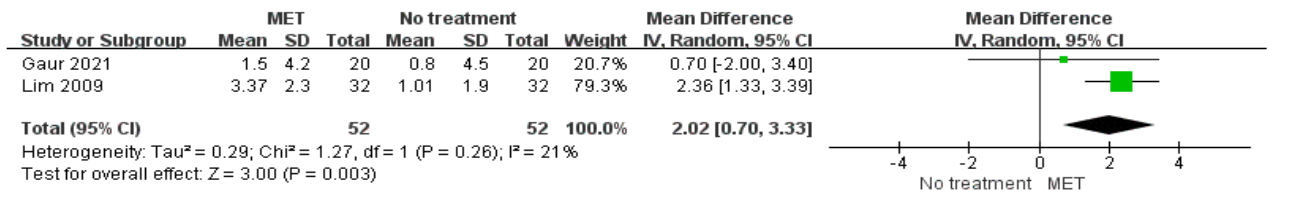
Figure 6. Meta-analysis of sit and reach test (SRT) outcomes compared between muscle energy technique (MET) and no-treatment groups [10,43]. SD: standard deviation; CI: confidence interval.